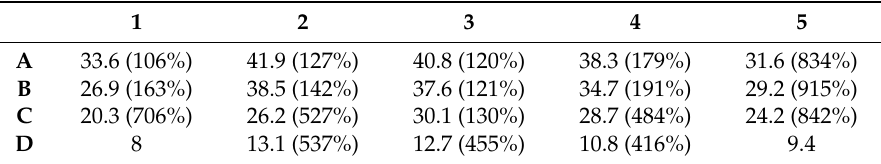
Table 11. SNR (dB) of amplitude image captured during 75 s